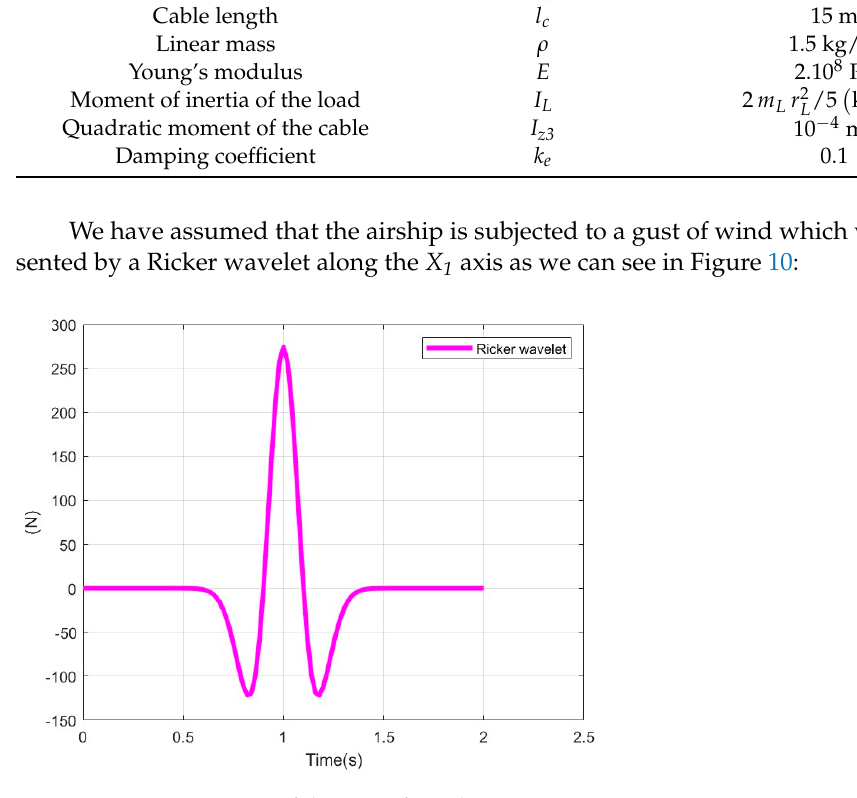
Figure 10. Representation of the gust of wind.